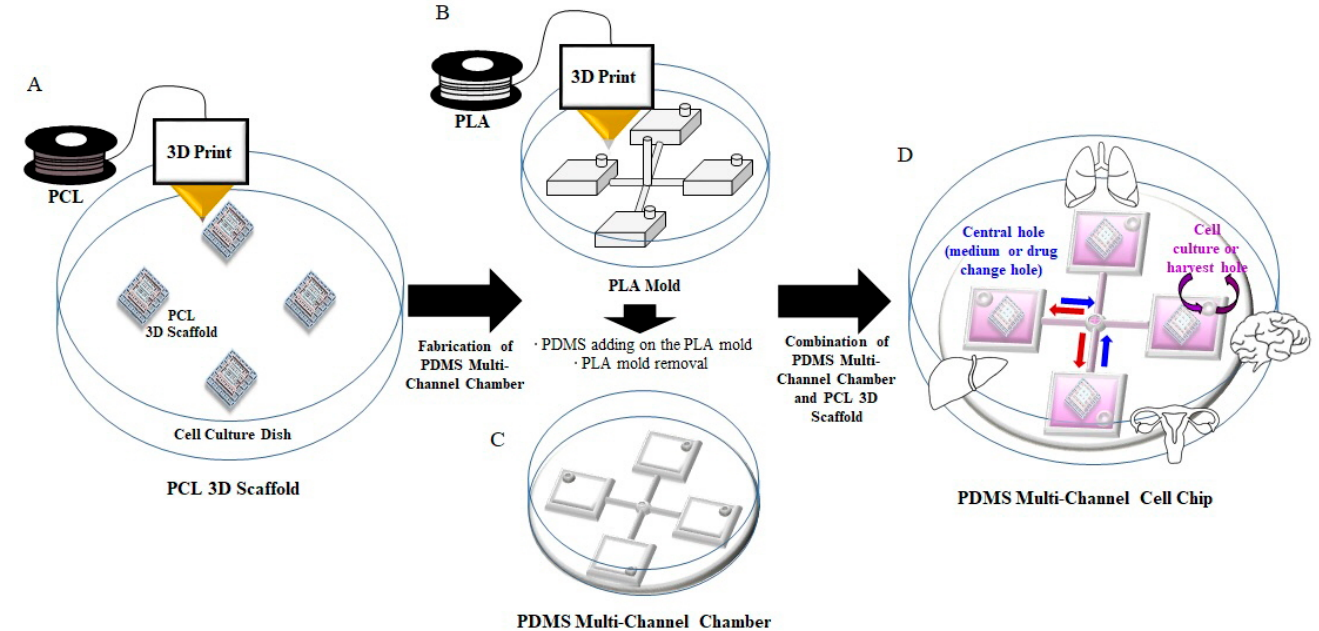
Figure 1. Schematic diagram of the polydimethylsiloxane (PDMS) multi-channel cell chip (PMCCC). ( A ) PCL 3D scaffold. ( B ) PLA mold. ( C ) PDMS multi-channel chamber. ( D ) PMCCC.